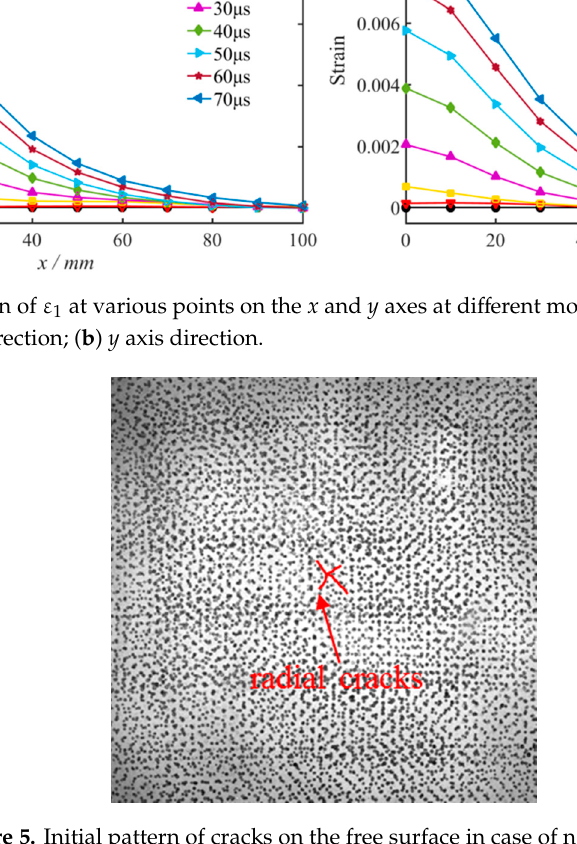
Figure 5. Initial pattern of cracks on the free surface in case of no static load.